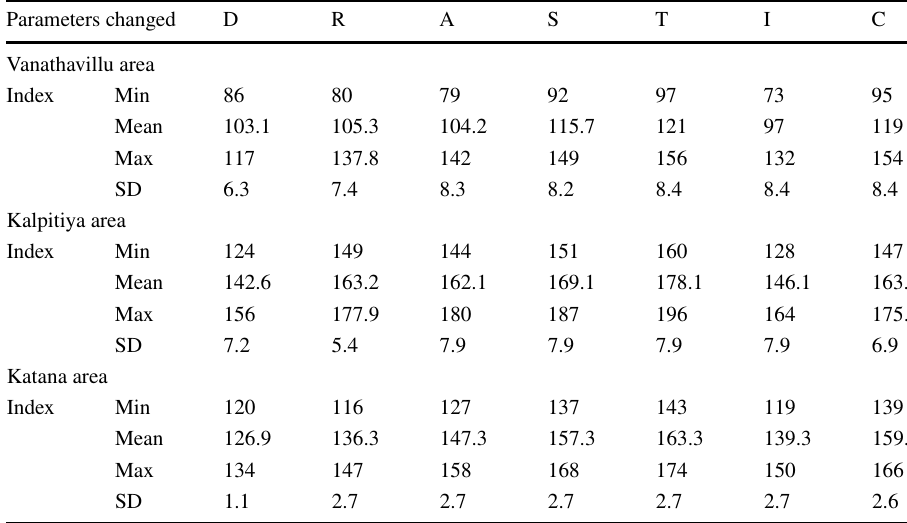
Parameters changed